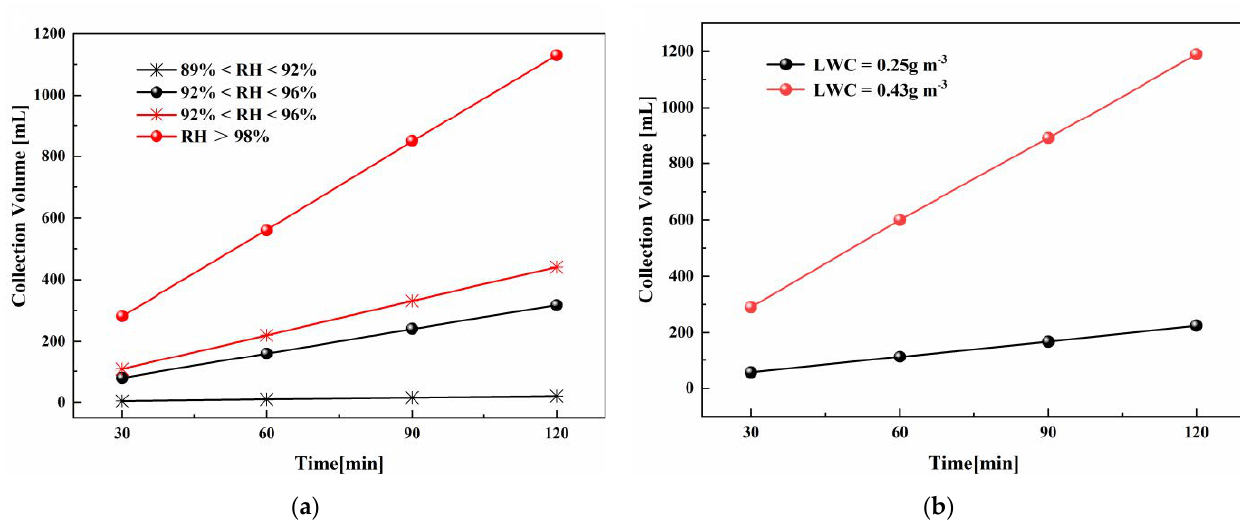
Figure 6. ( a ) The relationship between collection volume and duration of the sampler in different humidity ranges. ( b ) The relationship between collection volume and duration of the sampler at LWC = 0.25 g m −3 and LWC = 0.43 g m −3 .